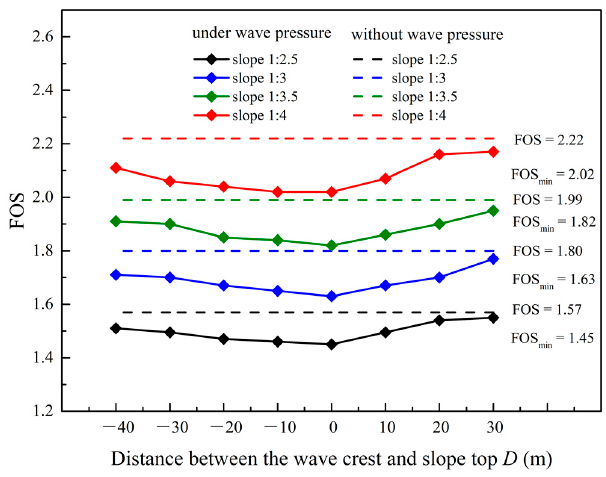
Figure 6. Variations of FOS with D in the cases of various slope ratios.